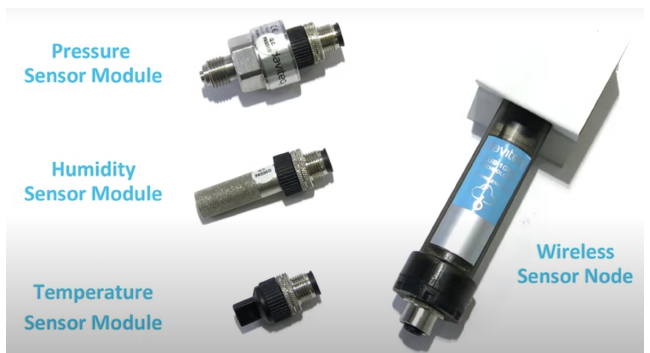
Figure 2. Different types of wireless sensor modules